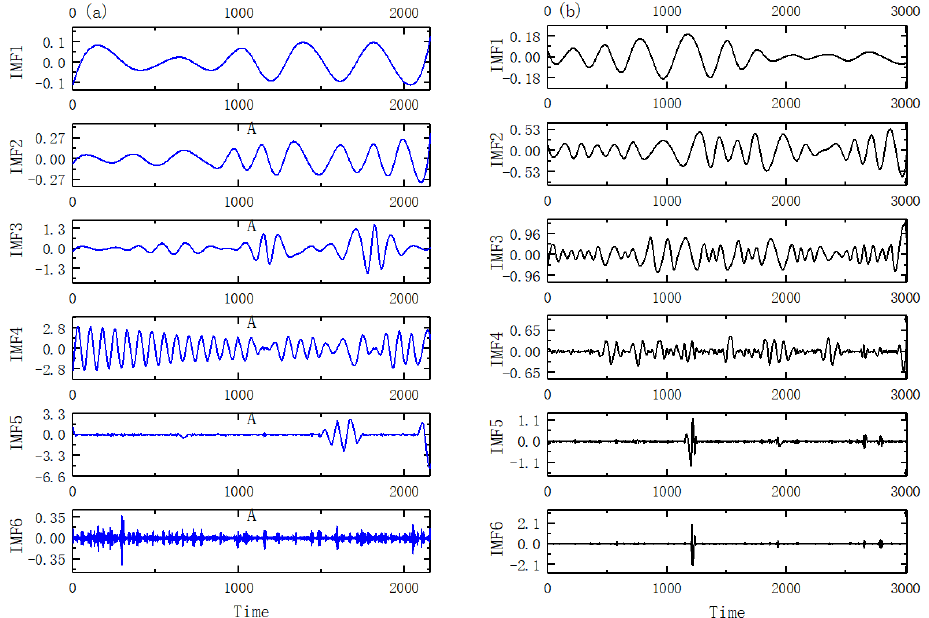
Figure 6. VMD decomposition based on the station retrieval data: ( a ) for the BRST station; ( b ) for the HKQT station. Table 1 . Index T value of the different IMFs of BRST station retrieval .